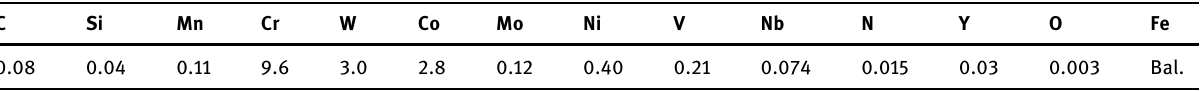
Table 1: Composition of the as - cast 9Cr3W3Co - ODS steel ( wt% )